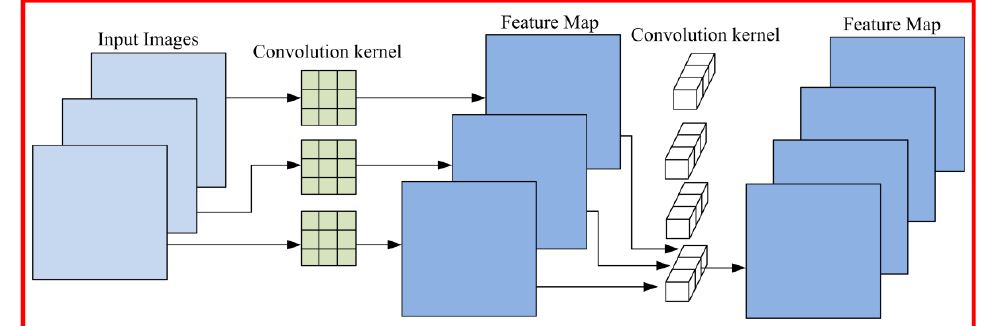
Figure 3. Calculation of Conv dw.